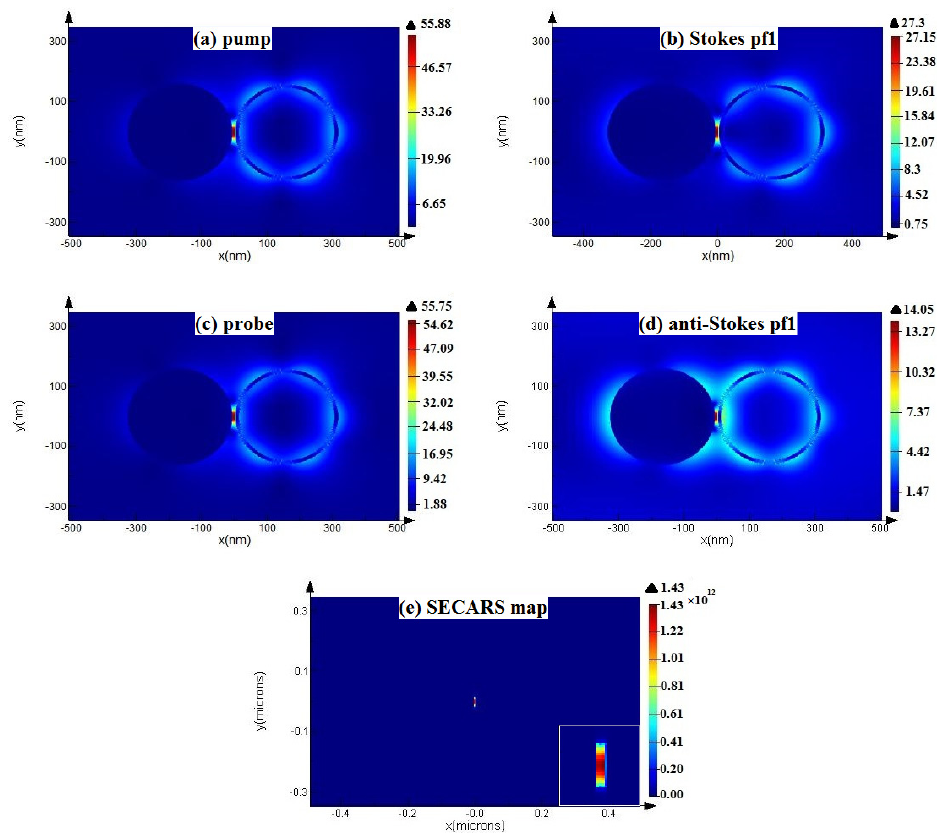
Figure 8. Transient distributions of the electric field of ( a ) pump, ( b ) Stokes, ( c ) probe, ( d ) anti-Stokes light, and ( e ) the corresponding SECARS map at 7128.3 fs. The white box in ( e ) is an enlarged view of the area of 60 nm × 60 nm in the center of the disk-ring structure.